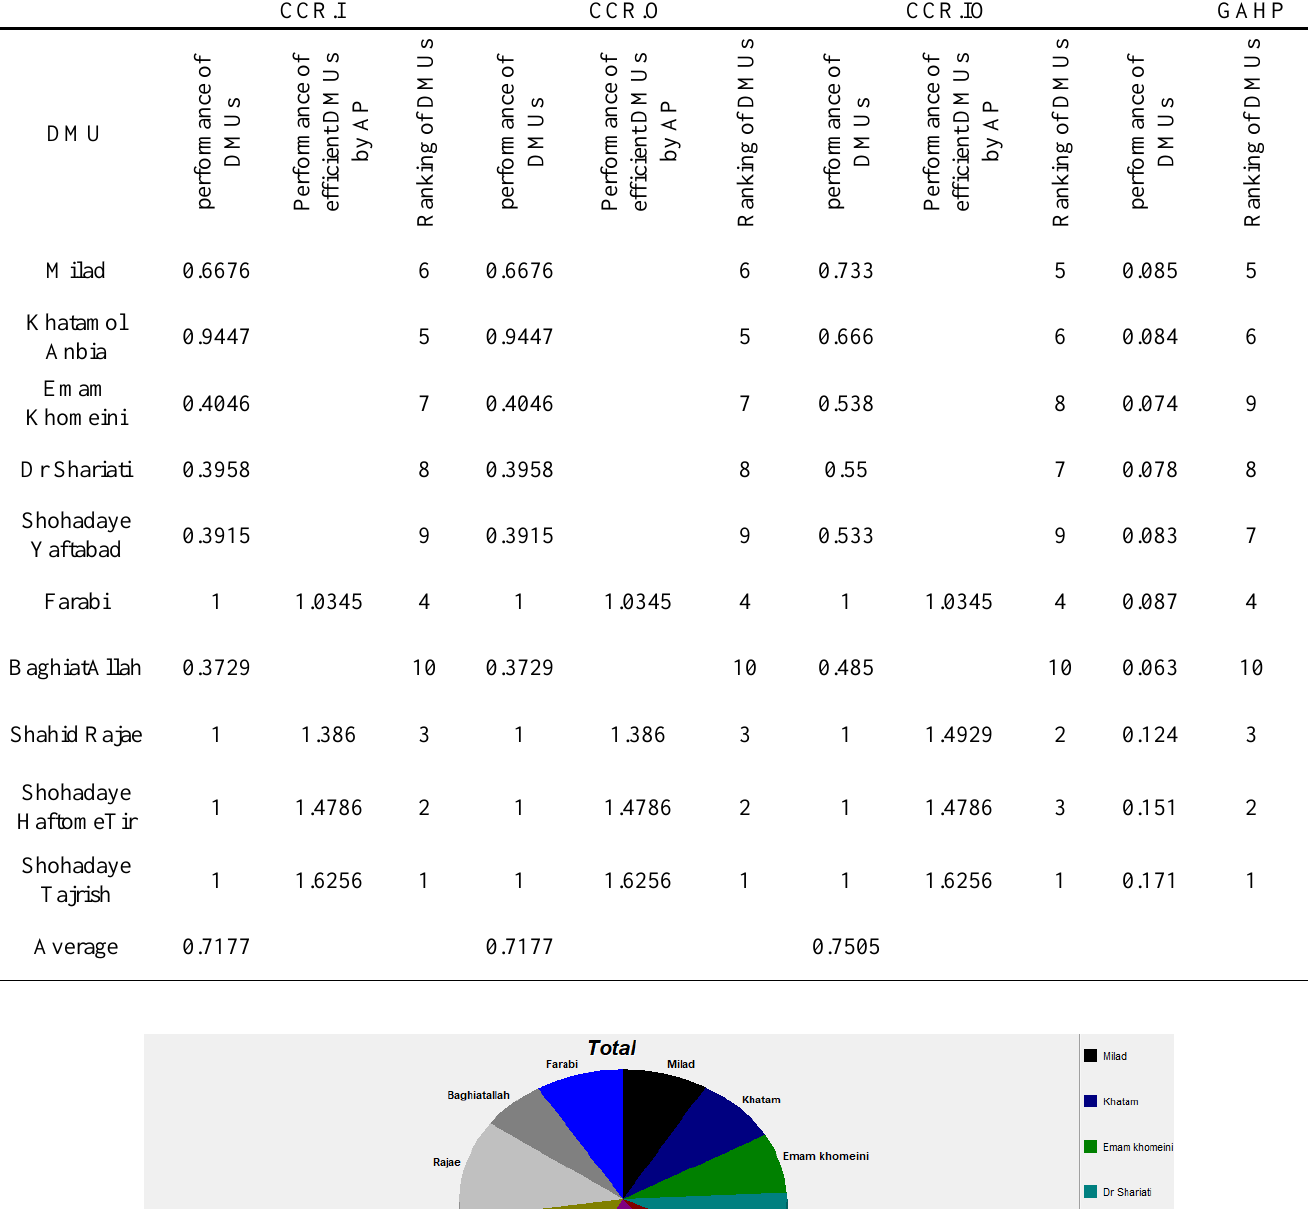
Table 6. Ranking of DMUs.